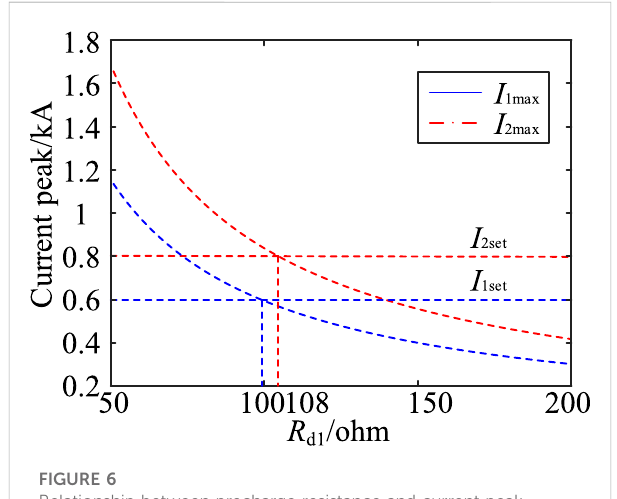
FIGURE 6 Relationship between precharge resistance and current peak.